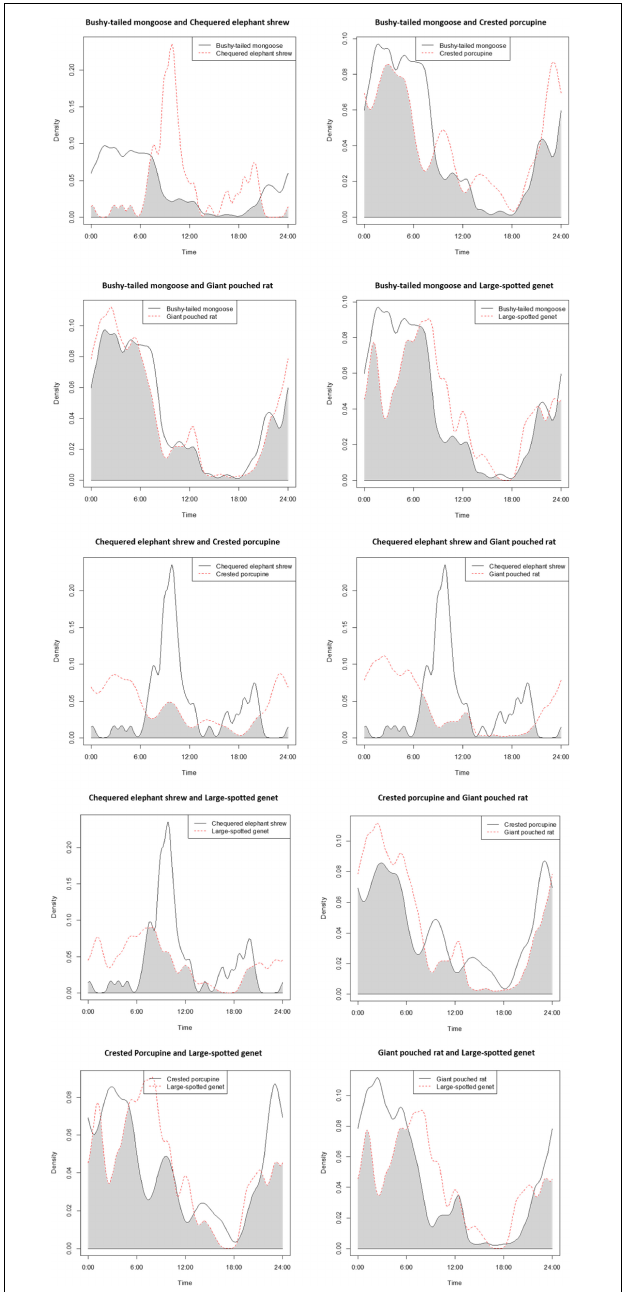
FIGURE 4 | Overlap in activity patterns between the five most common meso-mammal species in the Issa Valley, Tanzania. The plots show time over a 24-h period on the x-axis (note that at the latitude of Issa, sunrise is at about 06:00 h, and sunset at 18:00 h, throughout the year); and density of detection events, on the